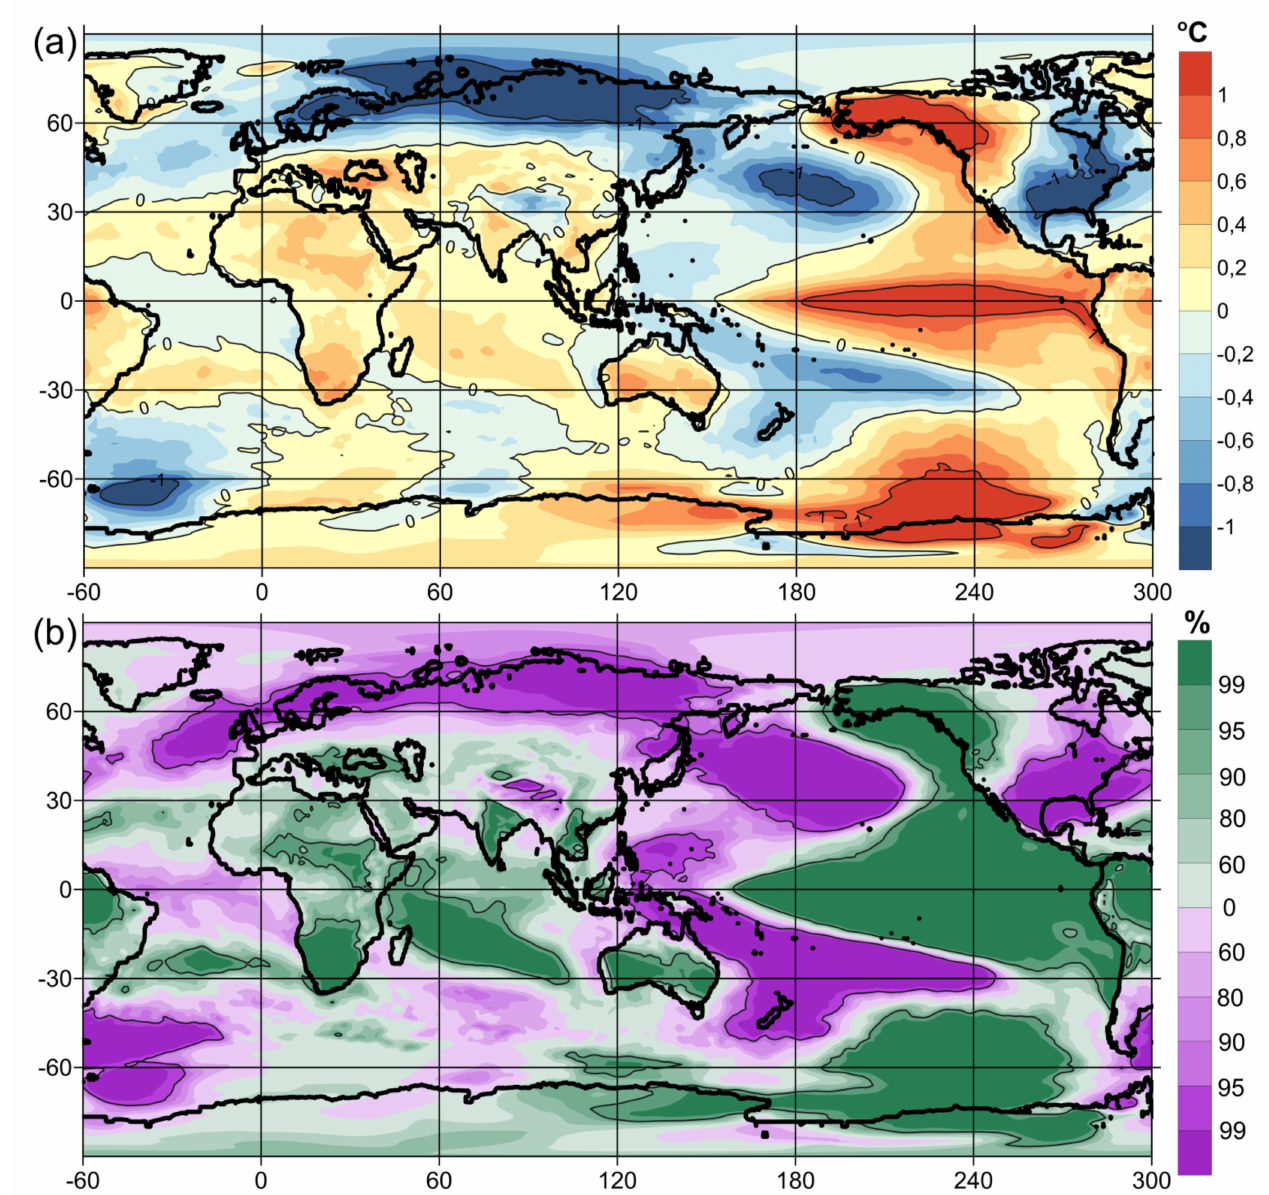
Figure 3. The difference in average air temperature anomalies at a height of 2 m from the surface between the opposite phases of the Global Atmospheric Oscillation by GAO2 index ( a ). The probability values for ( a ) according to Student’s t -test ( b